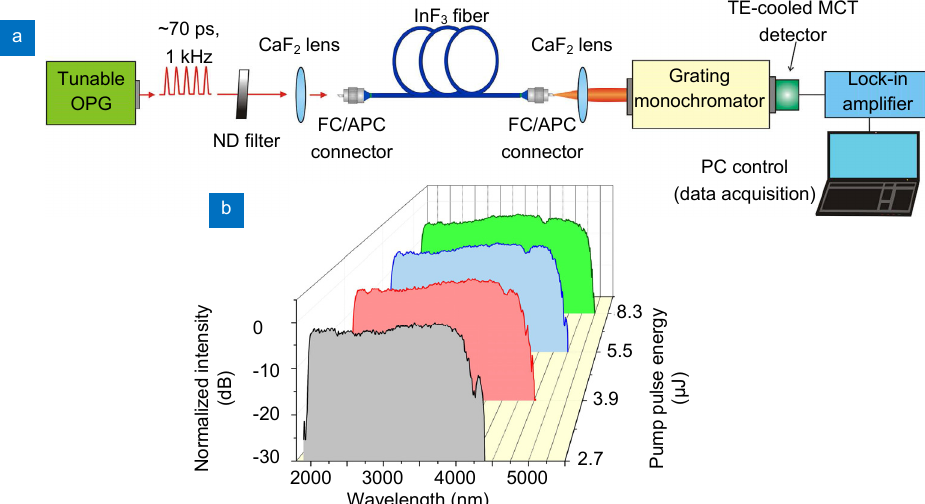
Fig.7 | Experimental setup and spectra for SC generation in the InF 3 fiber . ( a ) Experimental setup. ( b ) Evolution of SC spectrum with pump pulse energy. Figure reproduced from ref. 15